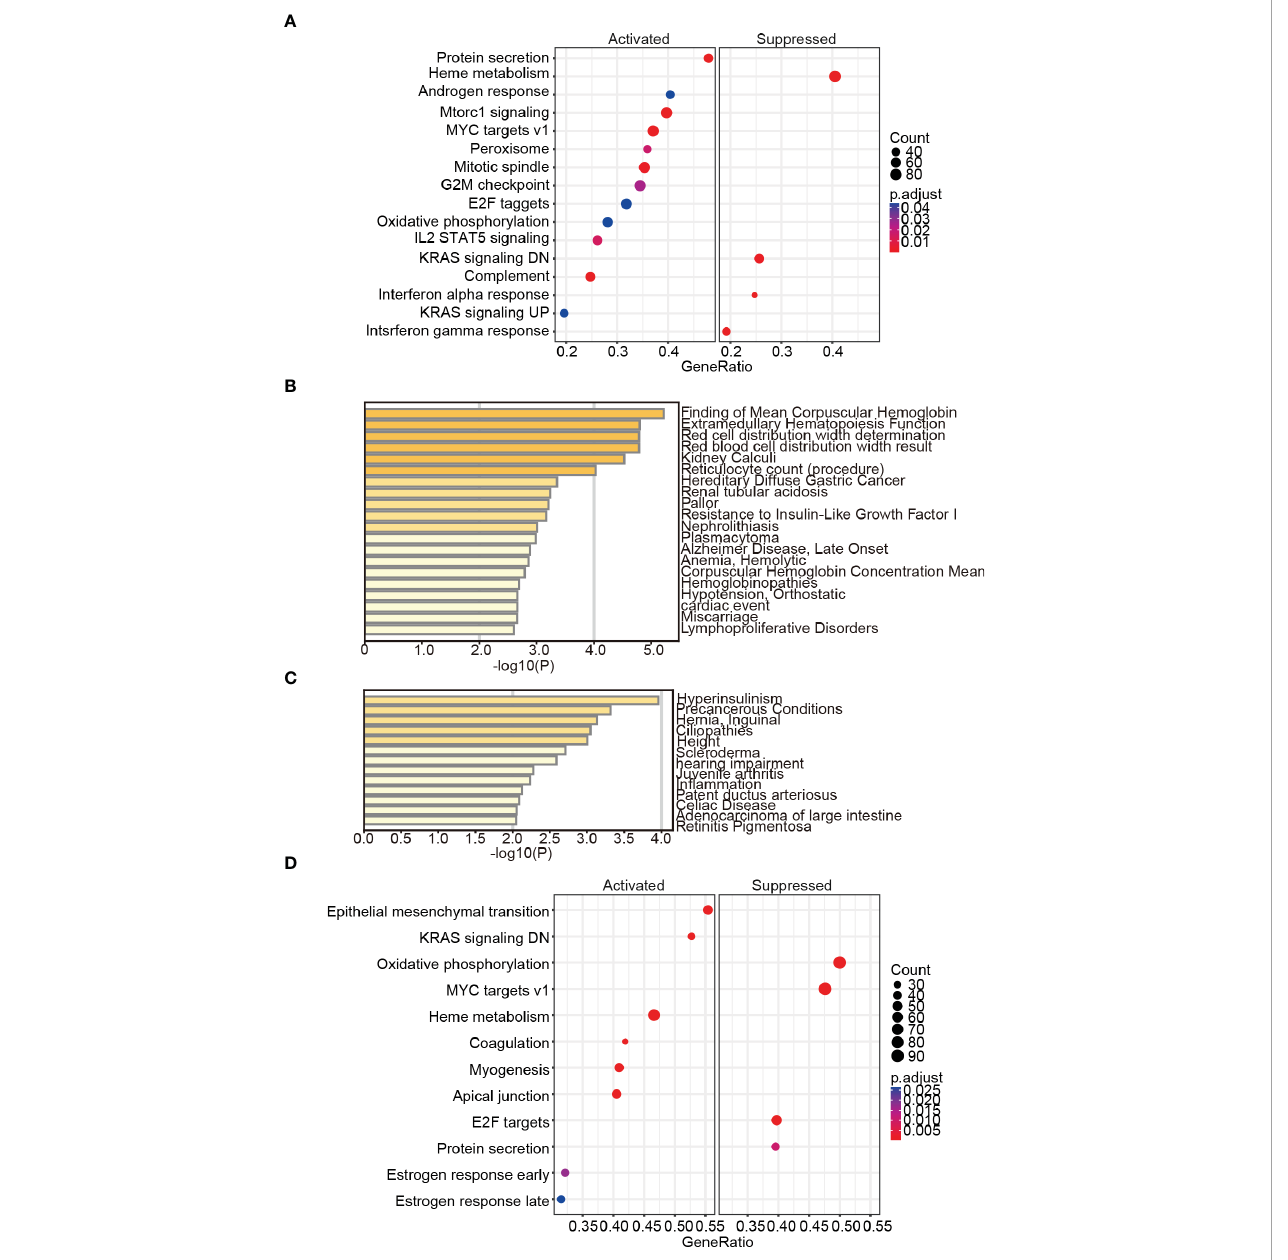
FIGURE 3 Gene enrichment analysis based on DisGeNET and GSEA. Summary of the enrichment analysis in DisGeNET in the children (A) and adult (B) groups. The GSEA results showed the enriched activated and suppressed pathways in children (C) and adults (D)